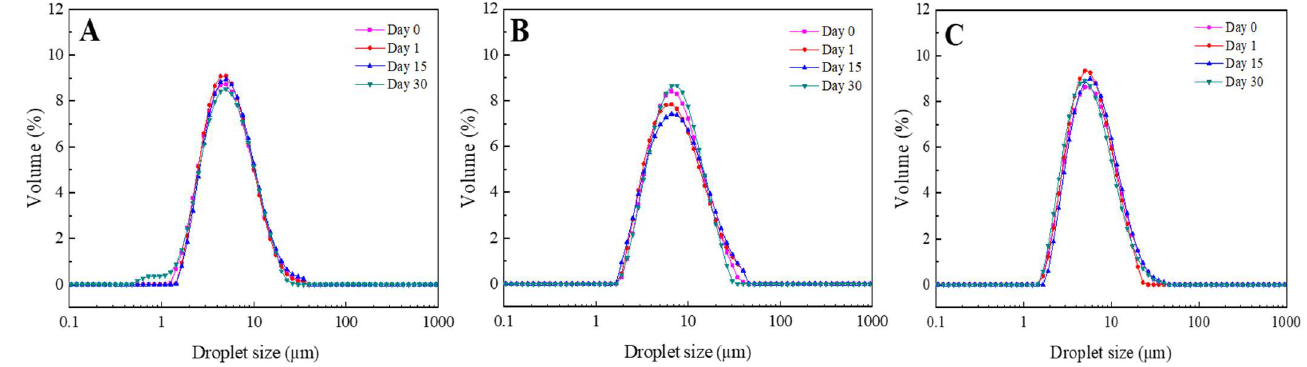
Figure 3. Droplet size distribution of W 1 /O/W 2 multiple emulsions obtained after three different O/W ratios for the secondary emulsion: 10/90 ( A ), 25/75 ( B ) and 40/60 ( C ). Table 5. Parameters from droplet size distribution (D 3,2 , span and FI) of W 1 /O/W 2 multiple emul- sions obtained after evaluating three different O/W ratios (10/90, 25/75 and 40/60) for the secondary emulsion over 30 days storage time. Different superscript letters within a column indicate signifi- cant differences ( p < 0.05).